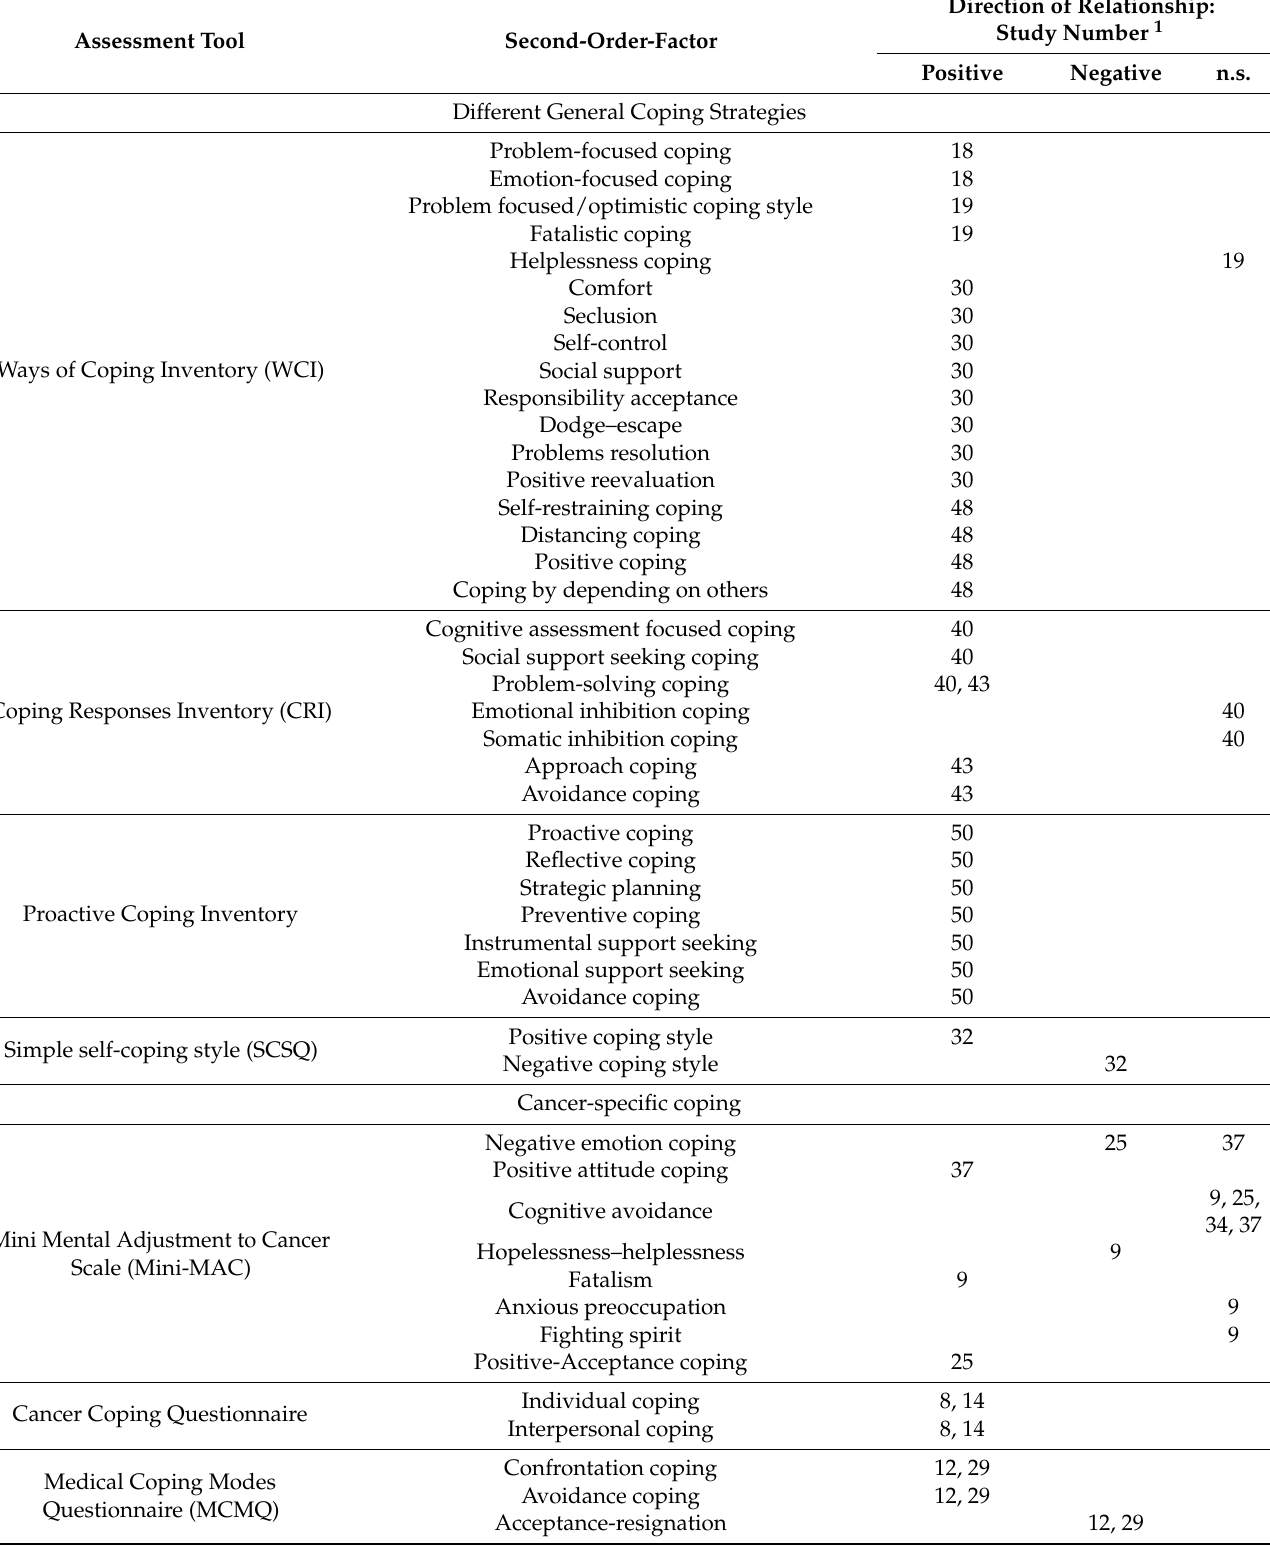
Table 7. Relationships of further coping strategies with the PTGI total